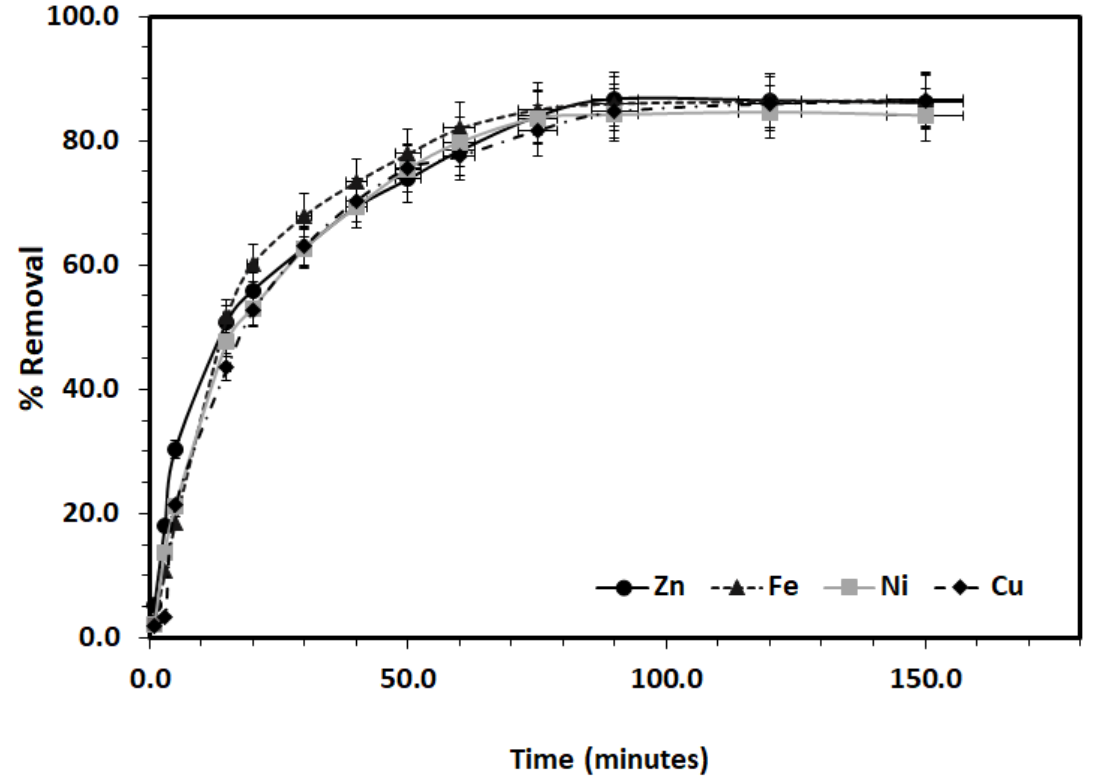
Water 2021 , 13 , x FOR PEER REVIEW Figure 6. Effect of HS nanoclay mass on the removal of metal ions (Zn, Fe, Ni, Cu) from a desalination plant outfall brine discharge. (Experimental conditions: 60.0 mL solution, pH 8.0, 90 min adsorption time, and 25 °C temperature).